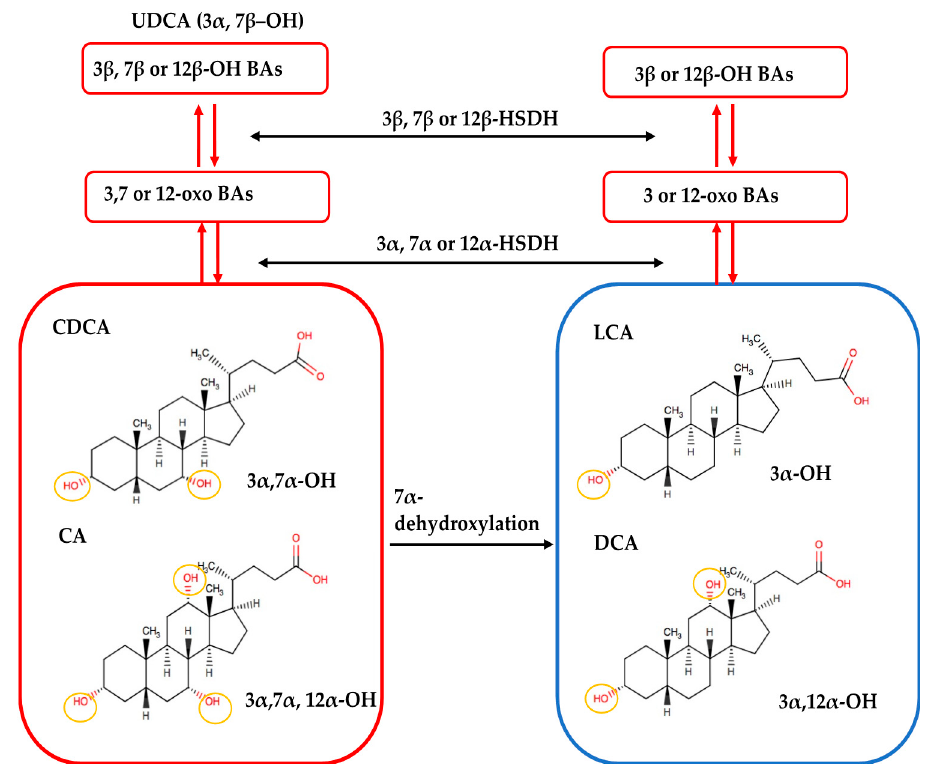
Figure 6. Microbial transformation of bile acids. CDCA and CA with 3, 7 and 3, 7, 12 α -hydroxyl groups are dehydroxylated by gut bacteria with 7 α -dehydroxylase to lose the hydroxyl group at the 7- α carbon position, forming LCA and DCA. Gut bacteria can further oxidize the hydroxyl groups at 3, 7, and 12 α -carbon positions with hydroxysteroid dehydrogenases (HSDH) activity to form oxo-bile acids. The resulting oxo groups may then undergo epimerization and reduction to form 3, 7, or 12 β -hydroxyl groups. Figure modified based on Ikegami and Honda, 2018 [35].